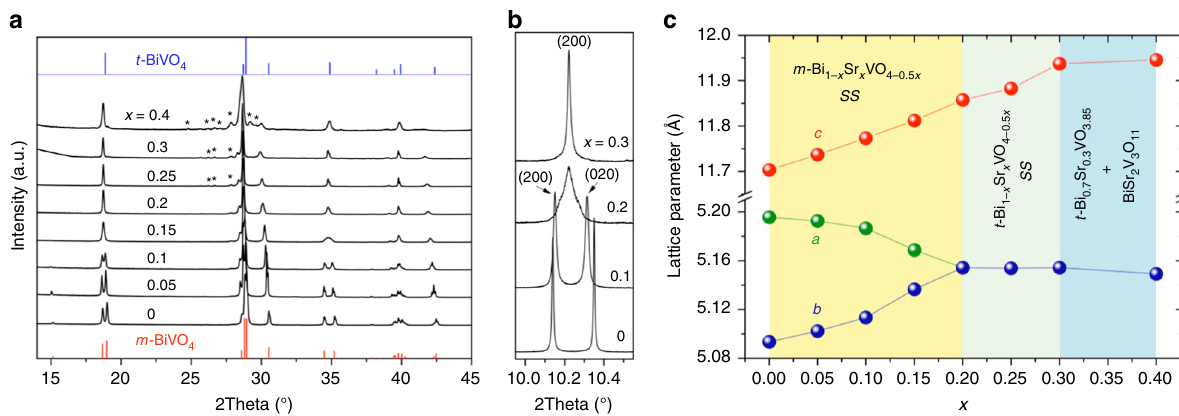
Fig. 2 The solid solubility limit of Bi 1 − x Sr x VO 4 − 0.5 x . a Ambient temperature laboratory XRD data of Bi 1 − x Sr x VO 4 − 0.5 x samples obtained by ADL synthesis. The red (bottom) and blue (top) vertical marks indicate the peak positions and relative intensities of monoclinic (no. 01-044-0081) and tetragonal (no. 01- 075-2481) BiVO 4 from the ICDD database, respectively. Asterisk marks indicate BiSr 2 V 3 O 11 secondary phase. b Merging of the monoclinic (200) and (020) re fl ections into single (200) re fl ection in the tetragonal phase from high-resolution SPD data. c Re fi ned cell parameters of Bi 1 − x Sr x VO 4 − 0.5 x solid solution (SS). The error bars are lying behind